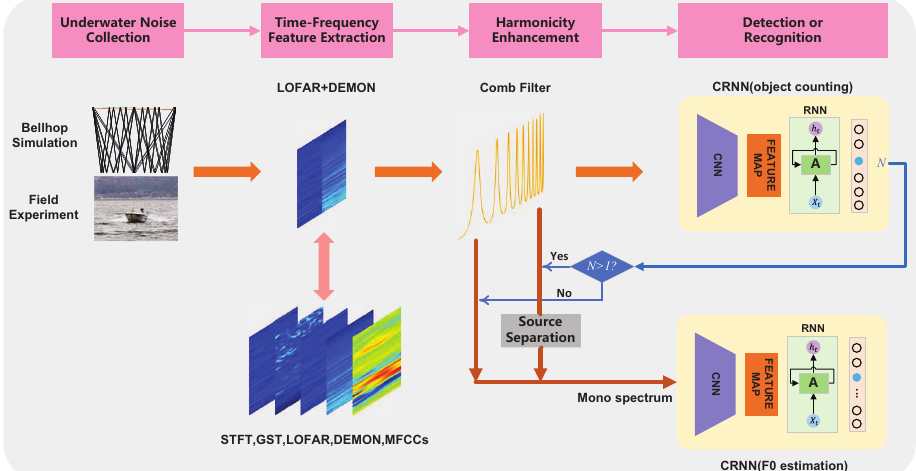
Figure 1. The pipeline of our proposed algorithm for underwater acoustic object counting and F 0 estimation. Again, when the target number N > 1, mixed spectra must be separated into mono spectrums before feeding into the CRNN, and related works will be present in a future report, which is not a concern in this